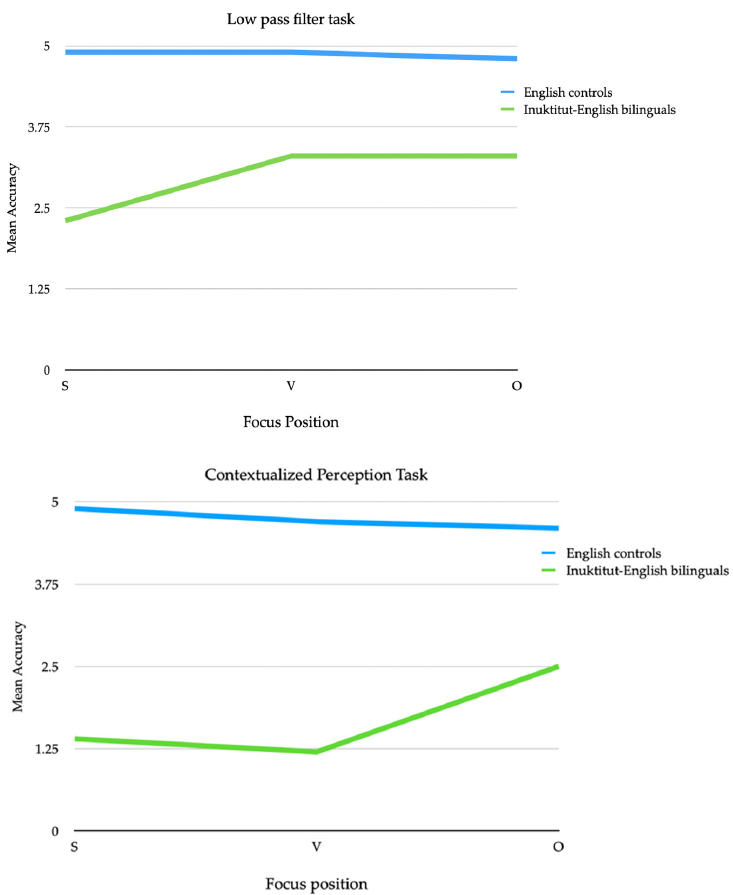
Figure 6. Mean correct responses (over five different stimuli) obtained from an auditory task ( top ) and a contextualized perception task ( bottom )—from Colantoni et al. (2014).